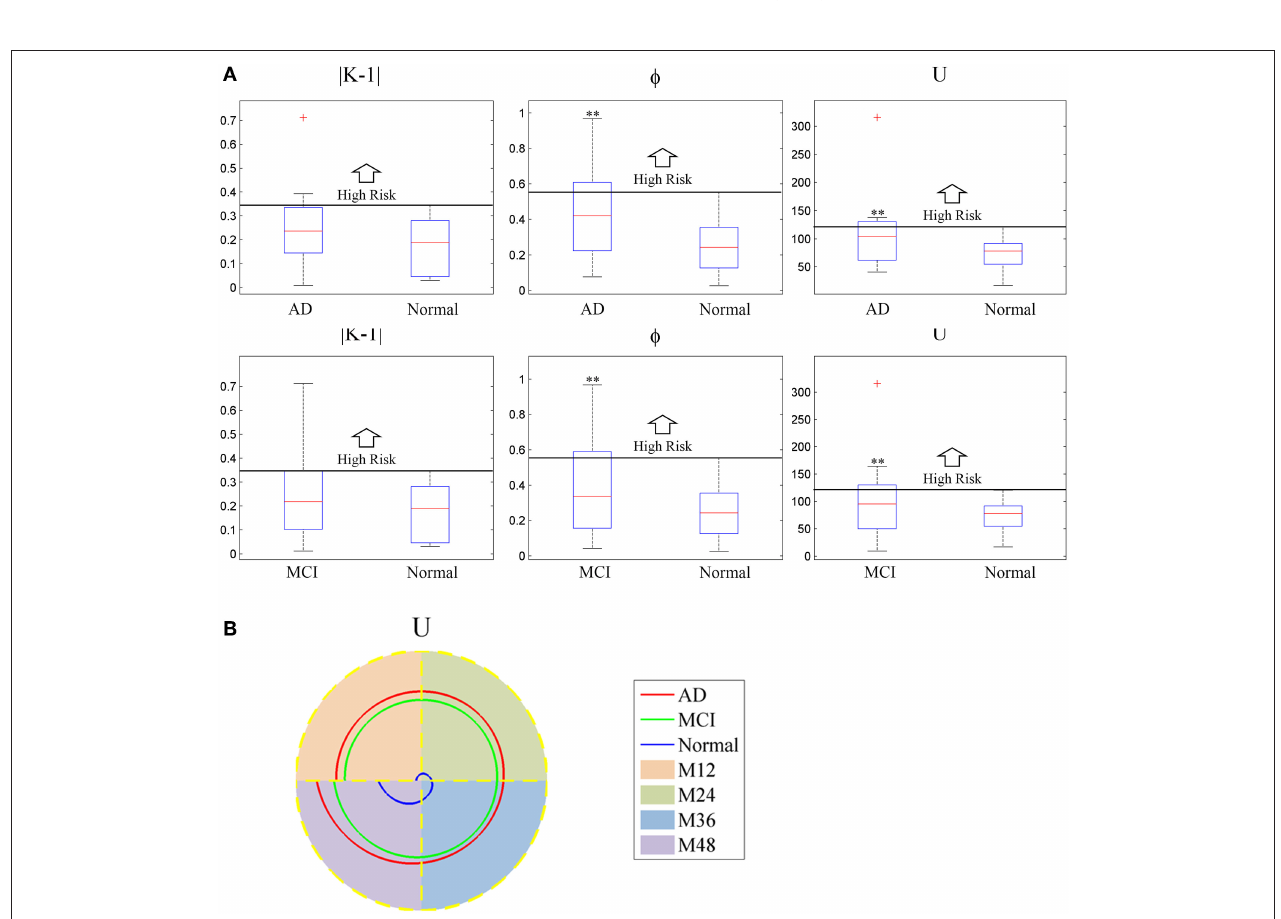
FIGURE 7 | (A) Box plot of mini network integral disruption parameters. “ + ” represents data points beyond the whiskers. (B) The trajectory figure of the mini network integral disruption parameter U . The different colors of the area under the curve indicate different time period. With the curves of U farther to the center, mini network imbalance gets worse. ** P < 0.01 vs.